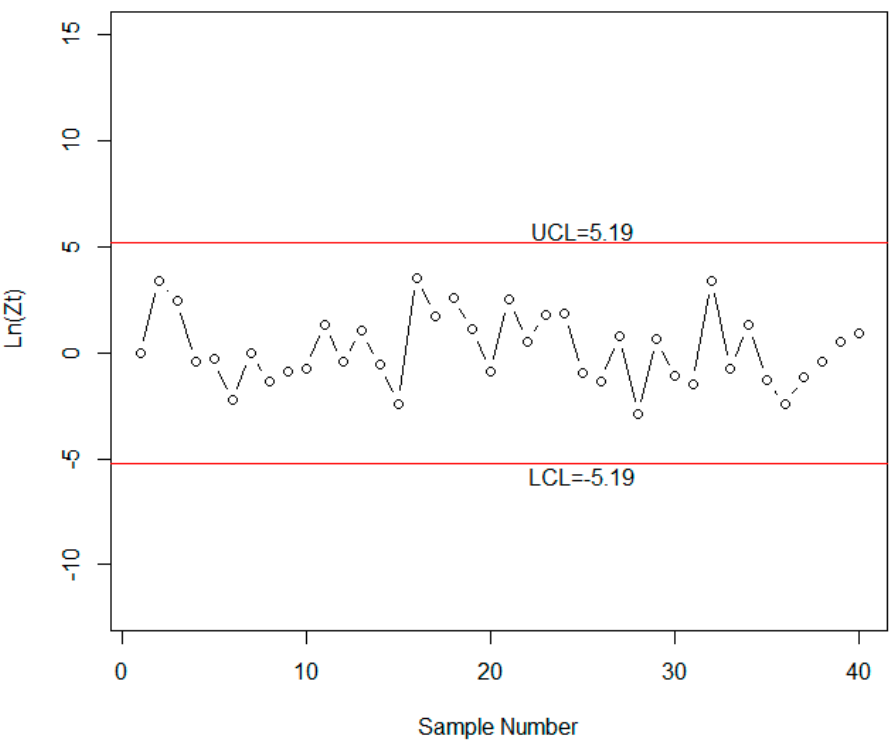
Figure 2. The existing chart for the simulated data.